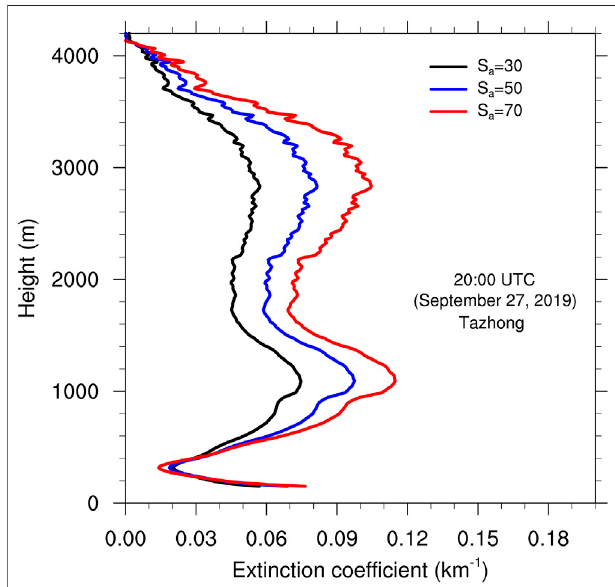
FIGURE 1 | Sensitivity study of different lidar ratio values ’ ( S a ) in fl uence on the inversion of aerosol extinction coef fi cient (km − 1 ) pro fi les at 20:00 UTC on September 27, 2019 at